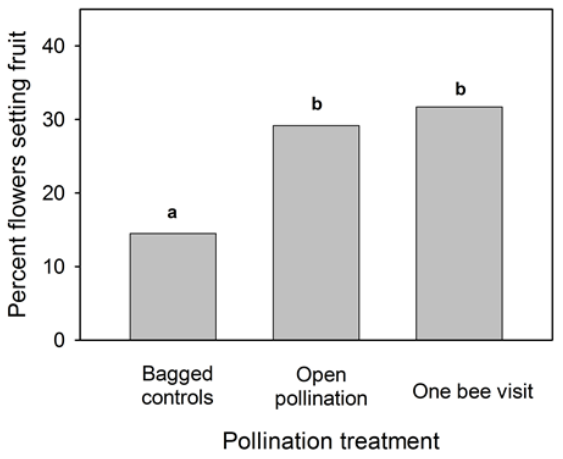
F IGURE 3. Percent of flowers setting fruit in closed and bagged flowers, flowers open to all visitors, and flowers visited by a single honeybee forager. Letters indicate percentages that are significantly different from each other at the P = 0.05 level.